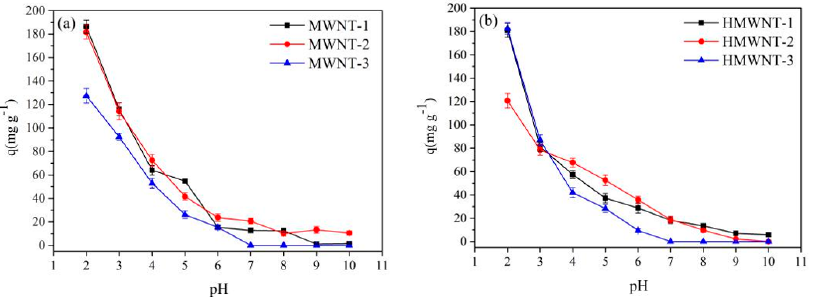
Figure 3. The effect of the solution pH on HA adsorption on the surfaces of MWNTs ( a ) and HMWNTs ( b ).